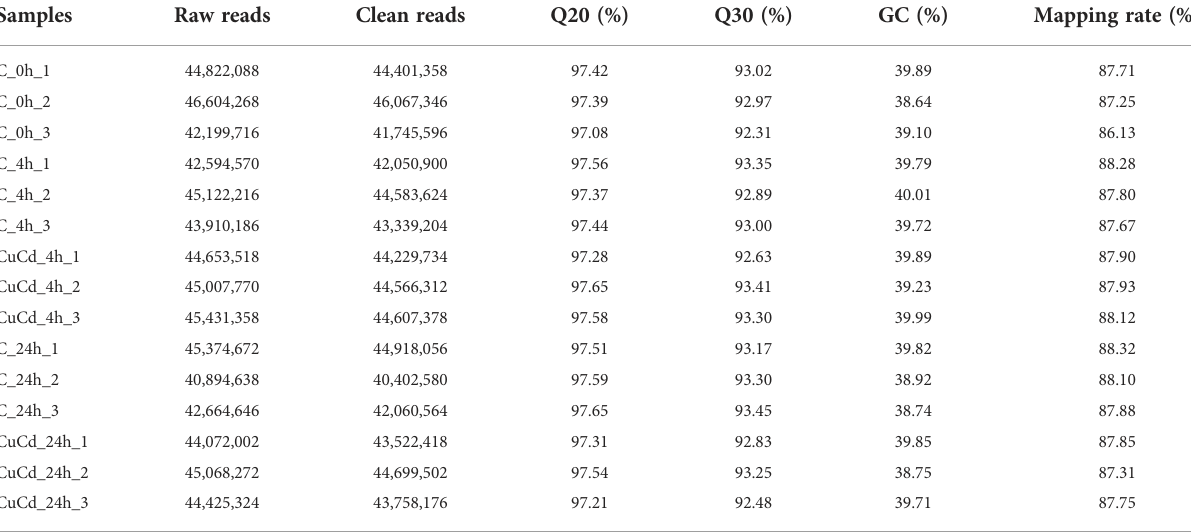
TABLE 2 Sequencing quality and mapping results.